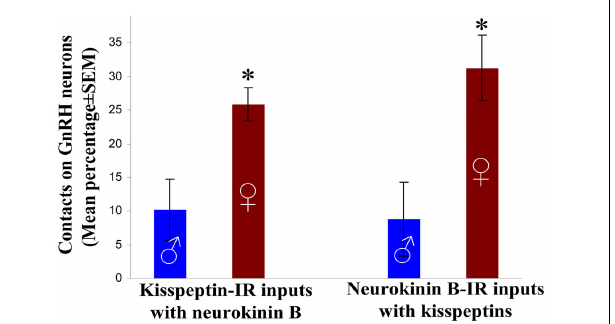
FIGURE 9 | Sex difference in the colocalization patterns of kisspeptins and preproNKB in neuronal afferents to GnRH neurons. As revealed on triple-immunofluorescent specimens, GnRH neurons receive kisspeptin-IR, preproNKB-IR, and double-labeled neuronal contacts.The percentage of kisspeptin-IR contacts that colocalized preproNKB signal is significantly higher in females (25.8 ± 2.4%) vs. males (10.2 ± 4.6%). Similarly, while only 8.8 ± 5.5% of preproNKB-IR afferents in males contain kisspeptin immunoreactivity, the extent of this colocalization is 31.3 ± 4.9% in females. ∗ P <